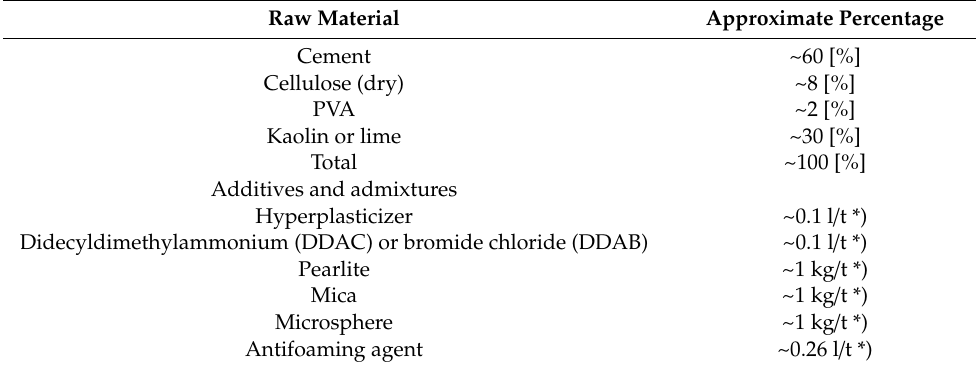
Table 1. Exemplary raw materials composition of fiber cement boards